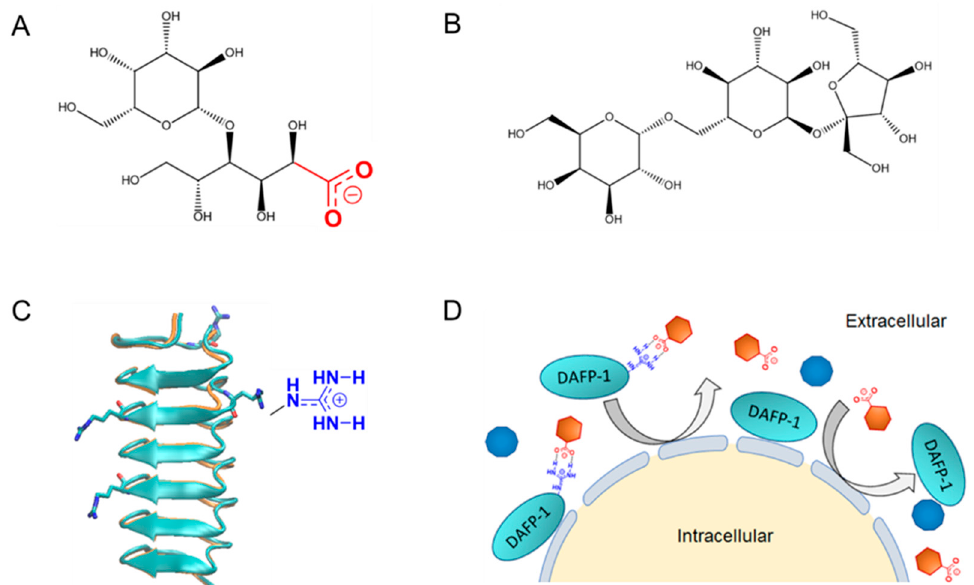
Figure 6. Structures and a schematic diagram for the enhancement effect. ( A ) Structure of raffinose with carboxylate group in red, ( B ) structure of lactobionate, and ( C ) structural overlay of DAFP-1 (cyan) and TmAFP (yellow–orange). The arginine residues in DAFP-1 are shown in licorice representation and colored by element (C in cyan, N in blue, O in red, and H removed for clarity). The guanidinium group (shown in blue) of an arginine residue is represented in a large aside of the protein’s structure. ( D ) Schematic representation of DAFP-1 enhancing the function of cell membrane impermeant compounds in UW solution, such as lactobionate (represented as negatively charged hexagons in orange) and raffinose (represented as decagons in blue).